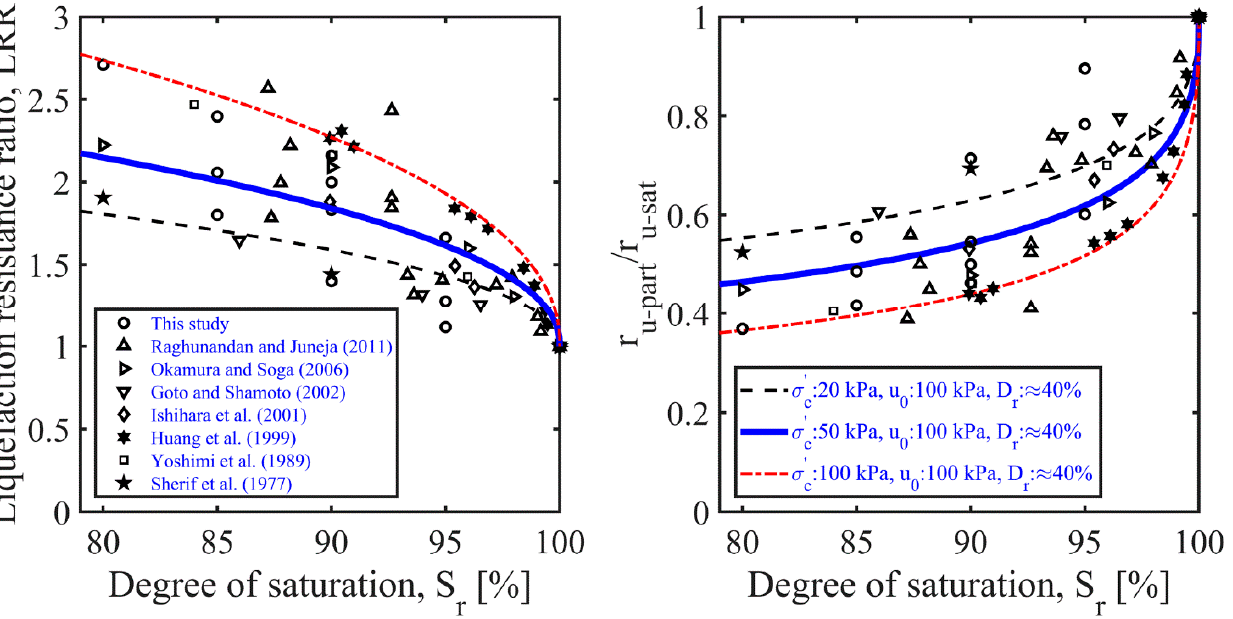
Figure 16. Validation of the predictions against elemental testing data [17,34–38,40].